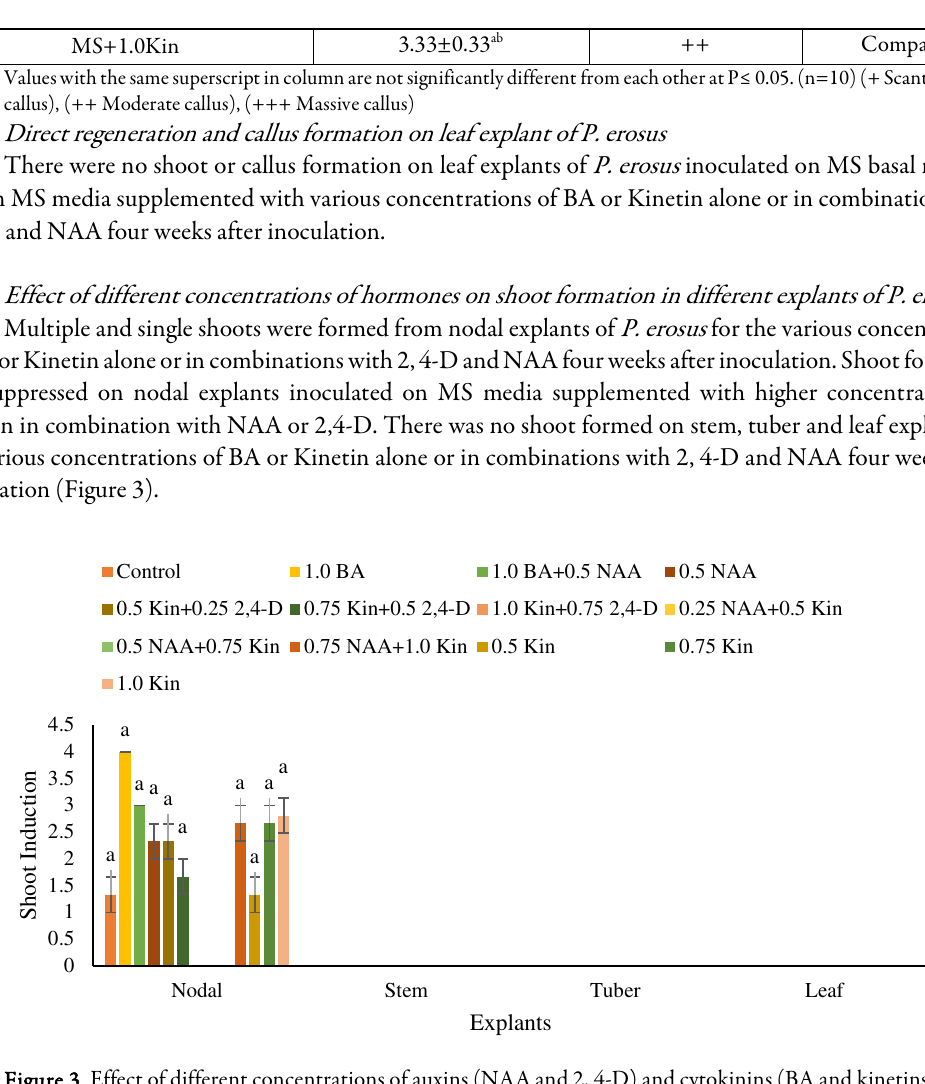
Figure 3. Effect of different concentrations of auxins (NAA and 2, 4-D) and cytokinins (BA and kinetins) on shoot formation in different explants of P. erosus Values with the same label across different plant organs (explants) are not significantly different from each other at P≤ 0.05.